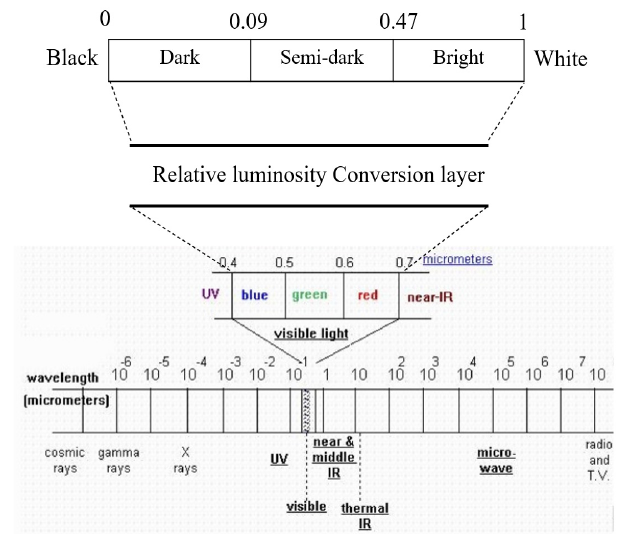
Figure 4. Relative luminance spectrum in visible light.